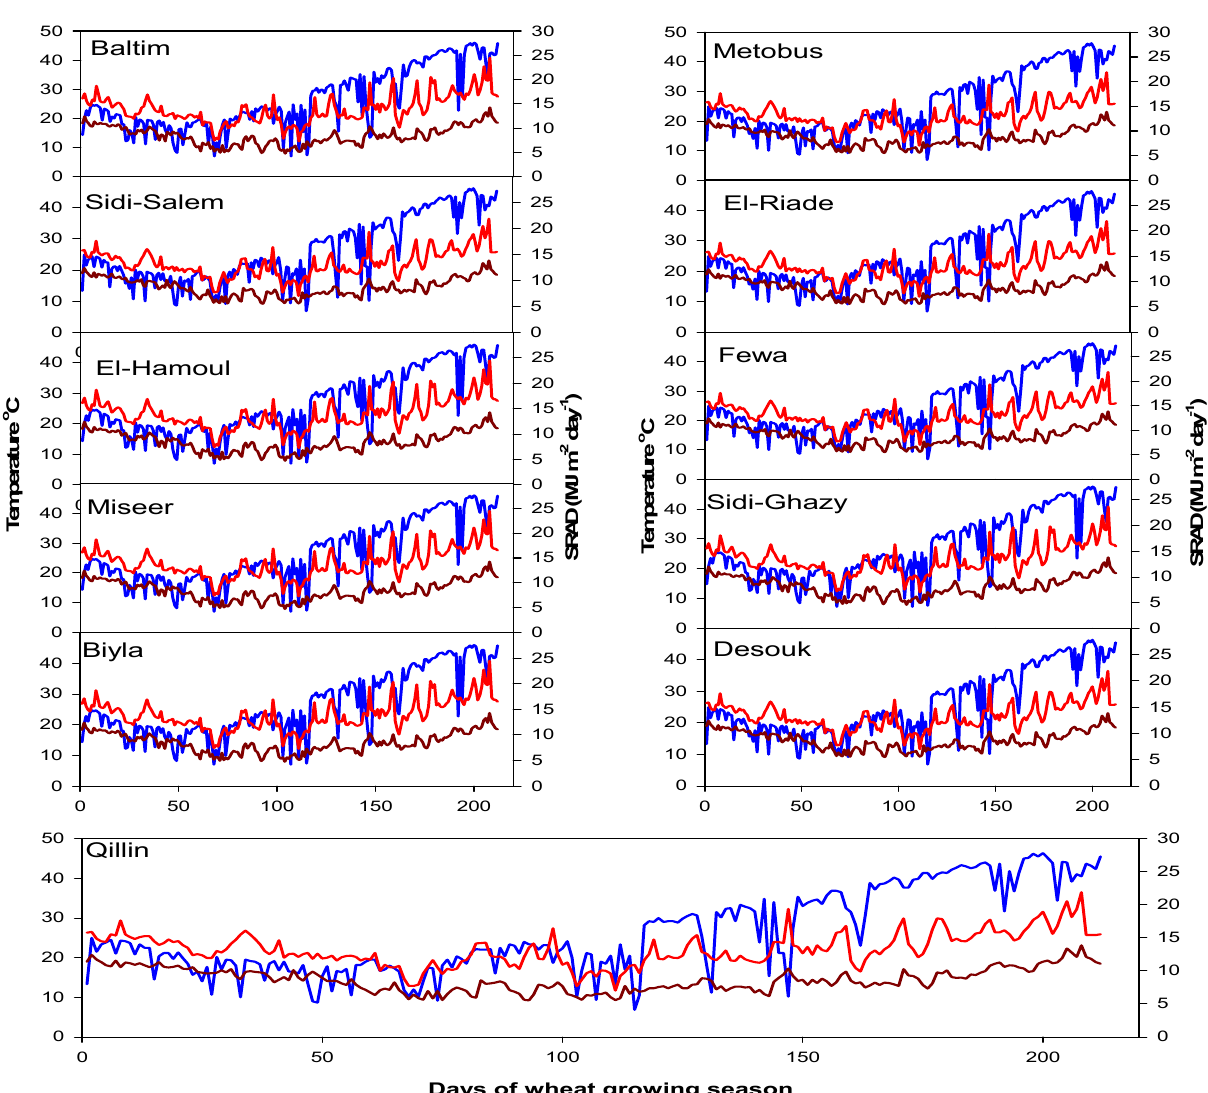
Figure 1. Daily maximum and minimum temperature (°C) and solar radiation (MJ m –2 day –1 ) data from all studied districts in the Kafr El Sheikh location. Data are required for yield predictions by the studied models. The colors blue, red, and dark red represent solar radiation and the maximum and minimum temperatures, respectively.